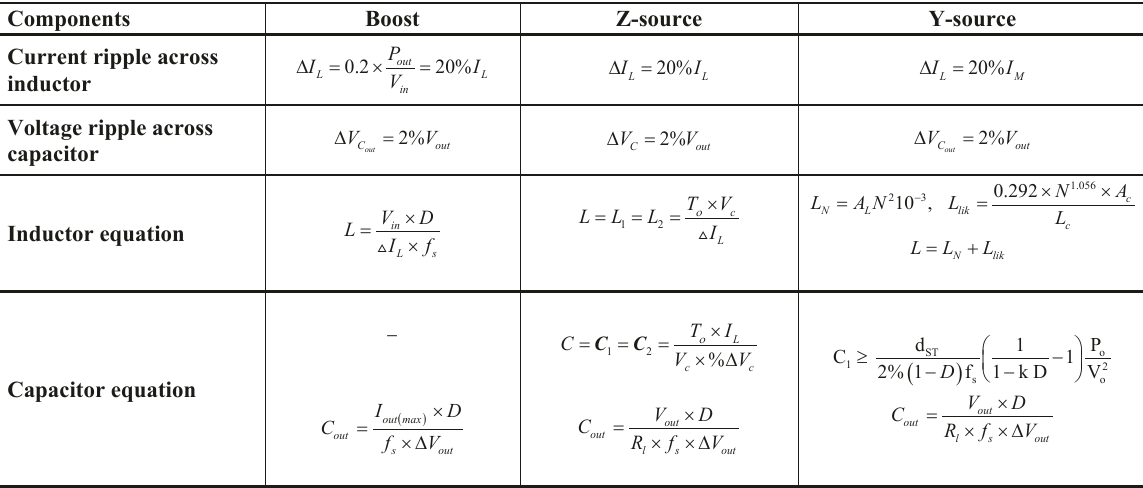
TABLE I. Component design for the Boost, Z-source and Y-source converters Components Boost Z-source Current ripple